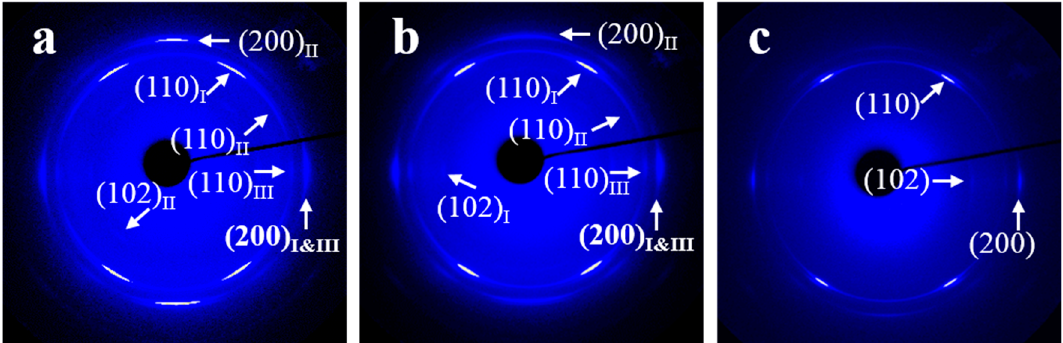
Figure 5. WAXD patterns with main reflections being indexed of a H-PCL/PVC blend films cooled from 100 °C down to 40 °C, immediately stretched to different draw ratios, and then crystallized at 40 °C under strain for varied times. ( a ) λ = 4, t c = 10 h; ( b ) λ = 5, t c = 8 h; ( c ) λ = 6, t c = 5 h. The stretching direction is vertical.